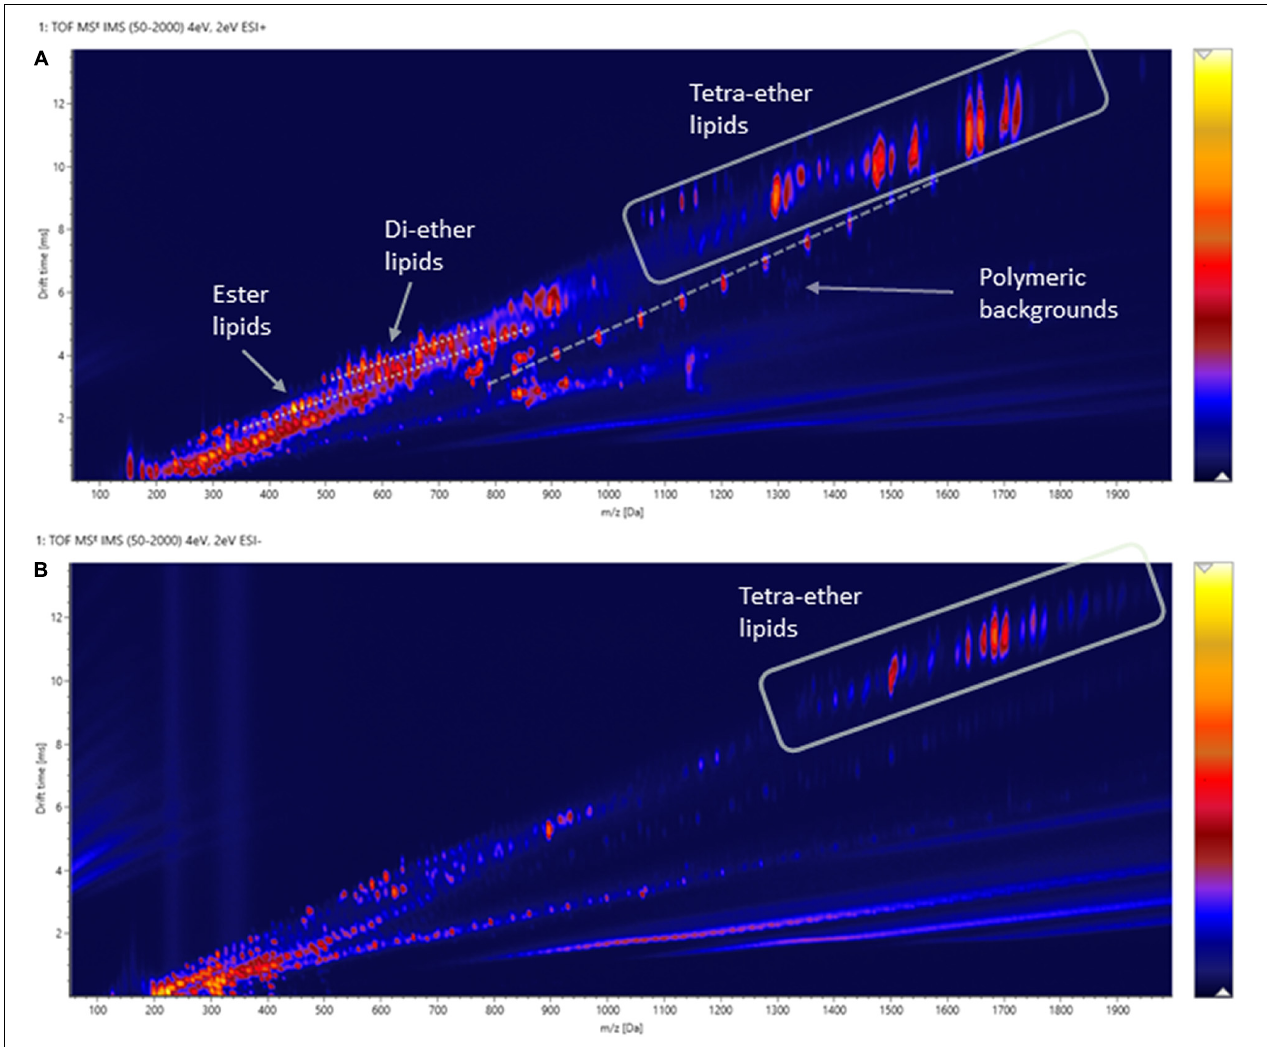
FIGURE 13 | Two-dimensional IM-MS spectra (drift-time- m/z plot) of an experimental cellular lipid extract acquired in (A) positive and (B) negative ionization modes.